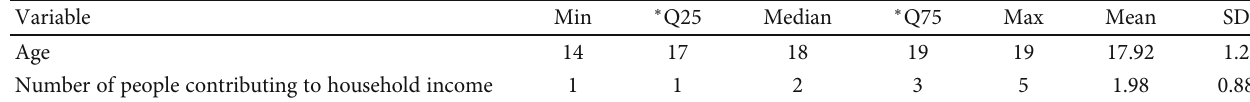
Table 1: Summary statistics of numerical variables ( n = 326